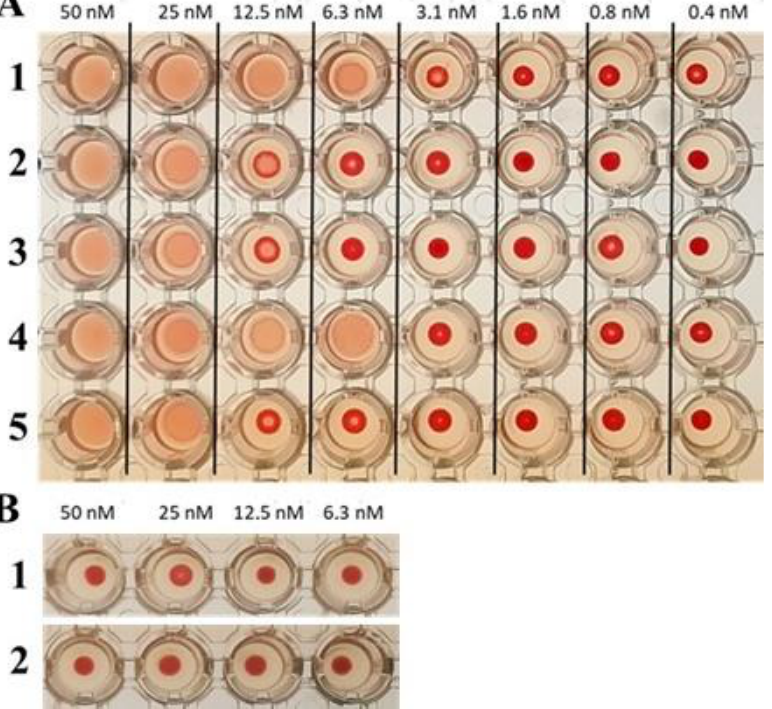
Figure 4. ( A ) Inhibition of agglutination of a 0.5% suspension of rabbit erythrocytes by monoclonal antibodies against HlyIILCTD. The upper line shows the concentration of HlyIILCTD in each column; 1, agglutination in the presence of HlyIILCTD; 2, agglutination in the presence of HlyIILCTD and 0.5 µ M MAb LCTD-70; 3, agglutination in the presence of HlyIILCTD and 0.5 µ M MAb LCTD-71; 4, agglutination in the presence of HlyIILCTD and 0.5 µ M MAb LCTD-75; 5, agglutination in the presence of HlyIILCTD and 0.5 µ M MAb LCTD-76. ( B ) The upper line shows the concentration of SlyD in each well; 1, in the presence SlyD; 2, in